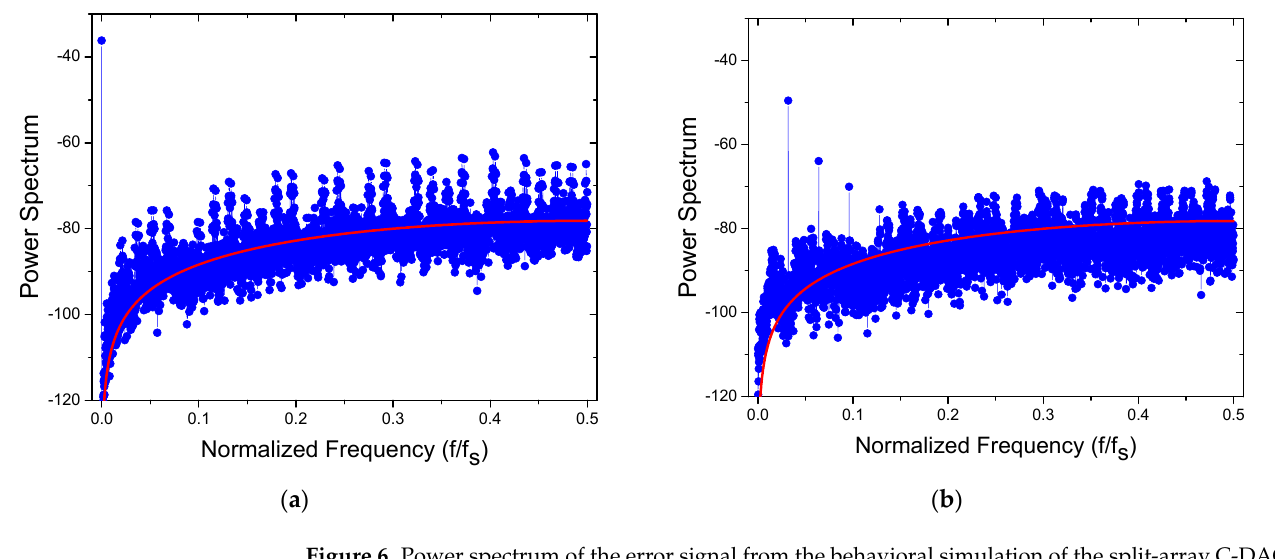
Figure 6. Power spectrum of the error signal from the behavioral simulation of the split-array C-DAC of Figure 4 with element rotations applied. N fft = 8192. Average of 100 iterations. ( a ) Two-level switching, ( b ) three-level switching.